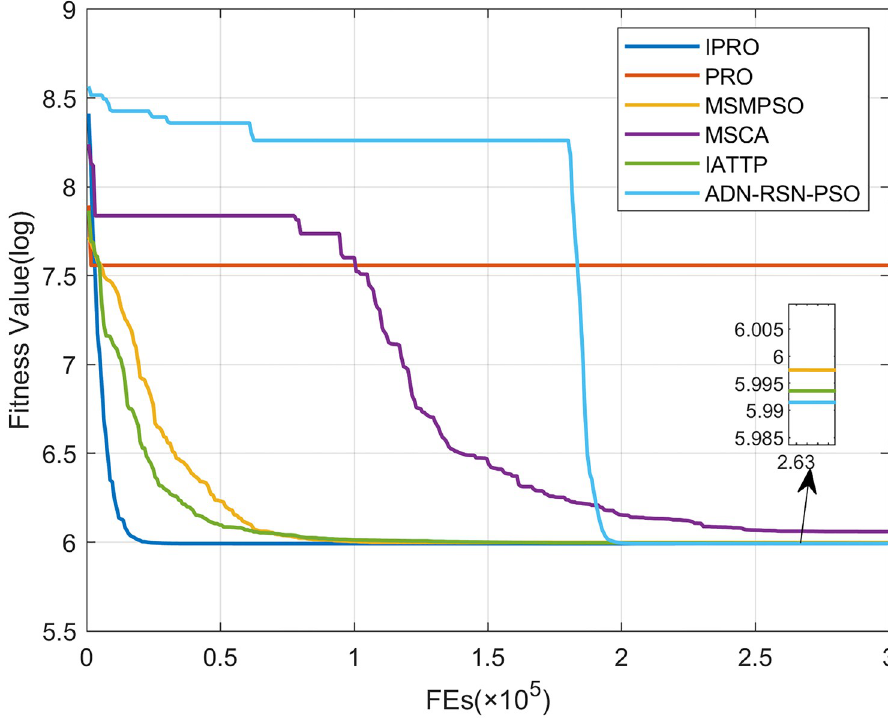
Fig 21. Convergence curves on F21.